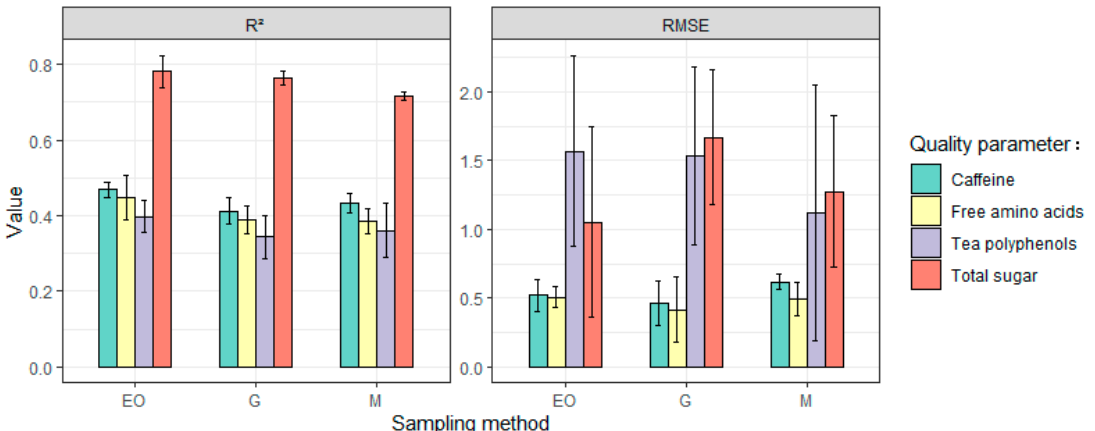
Figure 8. Accuracy (in terms of R 2 and RMSE) of the numerical models for different sampling methods. EO = EXG_Ostu, G = global, and M = manual. The error bar represents the standard error and RMSE is the unit (%).